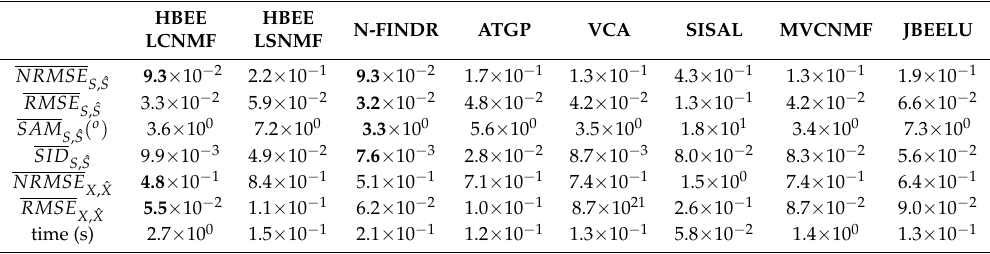
Table 7. Compared mean performances of the unmixing methods for the Basel data set. The mean has been computed with the 6 endmembers estimated by the methods.